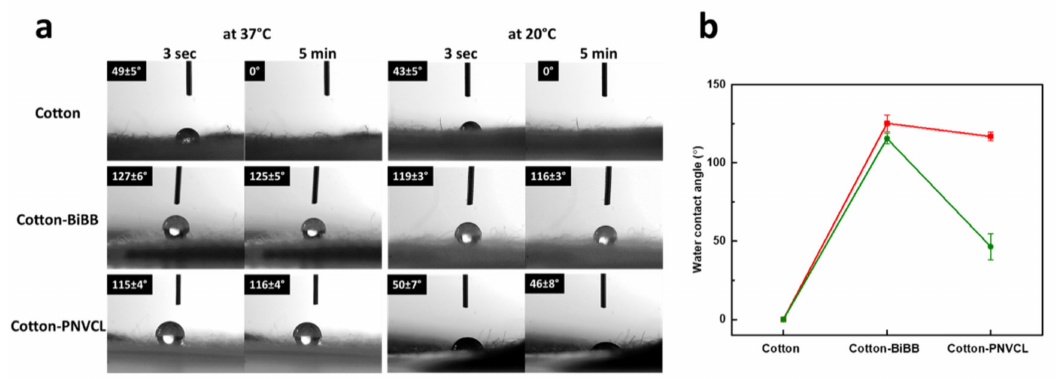
Figure 4. ( a ) Water contact angle (WCA) measurements at the surfaces of the cotton, cotton-BiBB, and cotton-PNVCL fabrics at 37 and 20 ◦ C, with photographs taken after drop times of 3 s and 5 min. ( b ) Quantitative analysis of the WCAs at 37 ◦ C (red) and 20 ◦ C (green) after a drop time of 5